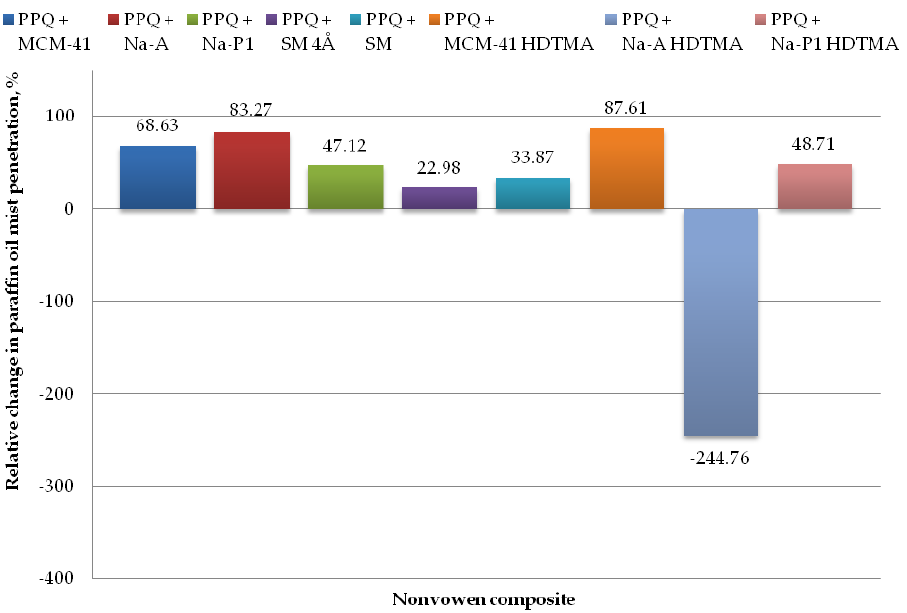
Figure 11. Relative change in paraffin oil mist aerosol penetration for nonwoven zeolite and silica composite.